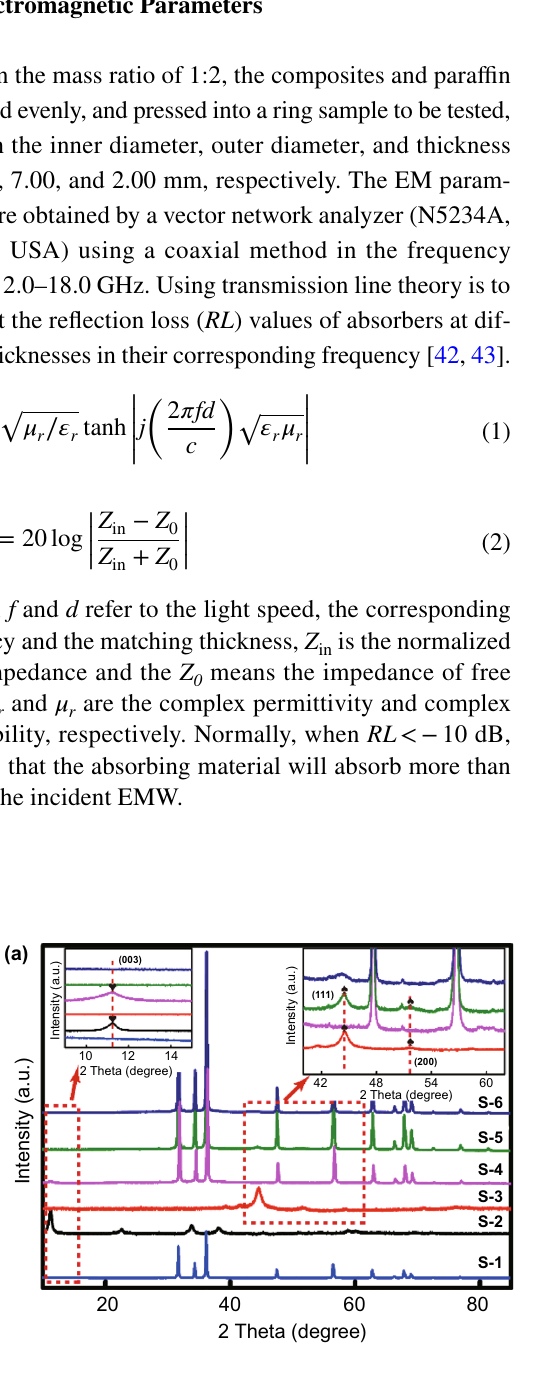
Fig. 1 a XRD patterns of all samples, b Raman spectrum of S-1, S-4, and